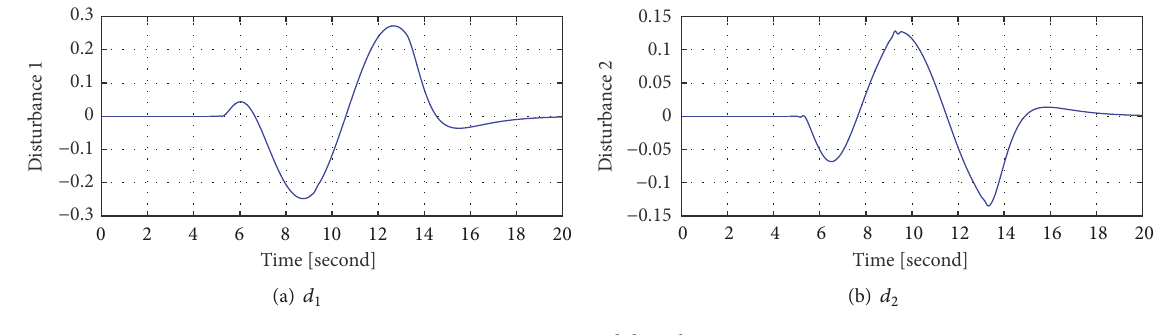
Figure 9: Estimated